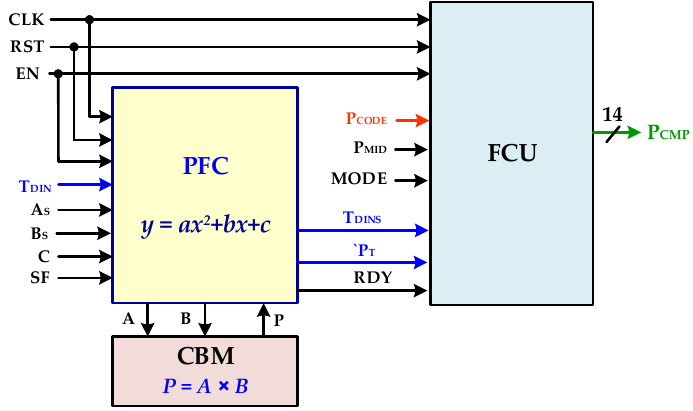
Figure 5. Proposed temperature-compensation controller (TCC) architecture.